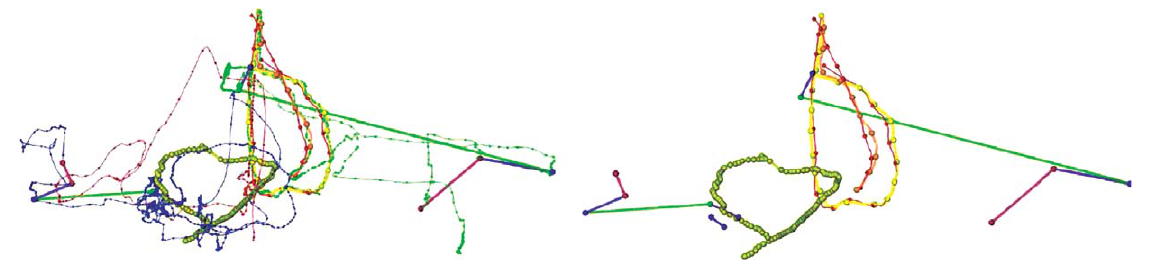
Fig. 5. Extracted primitives with original trajectory (left) and by themselves